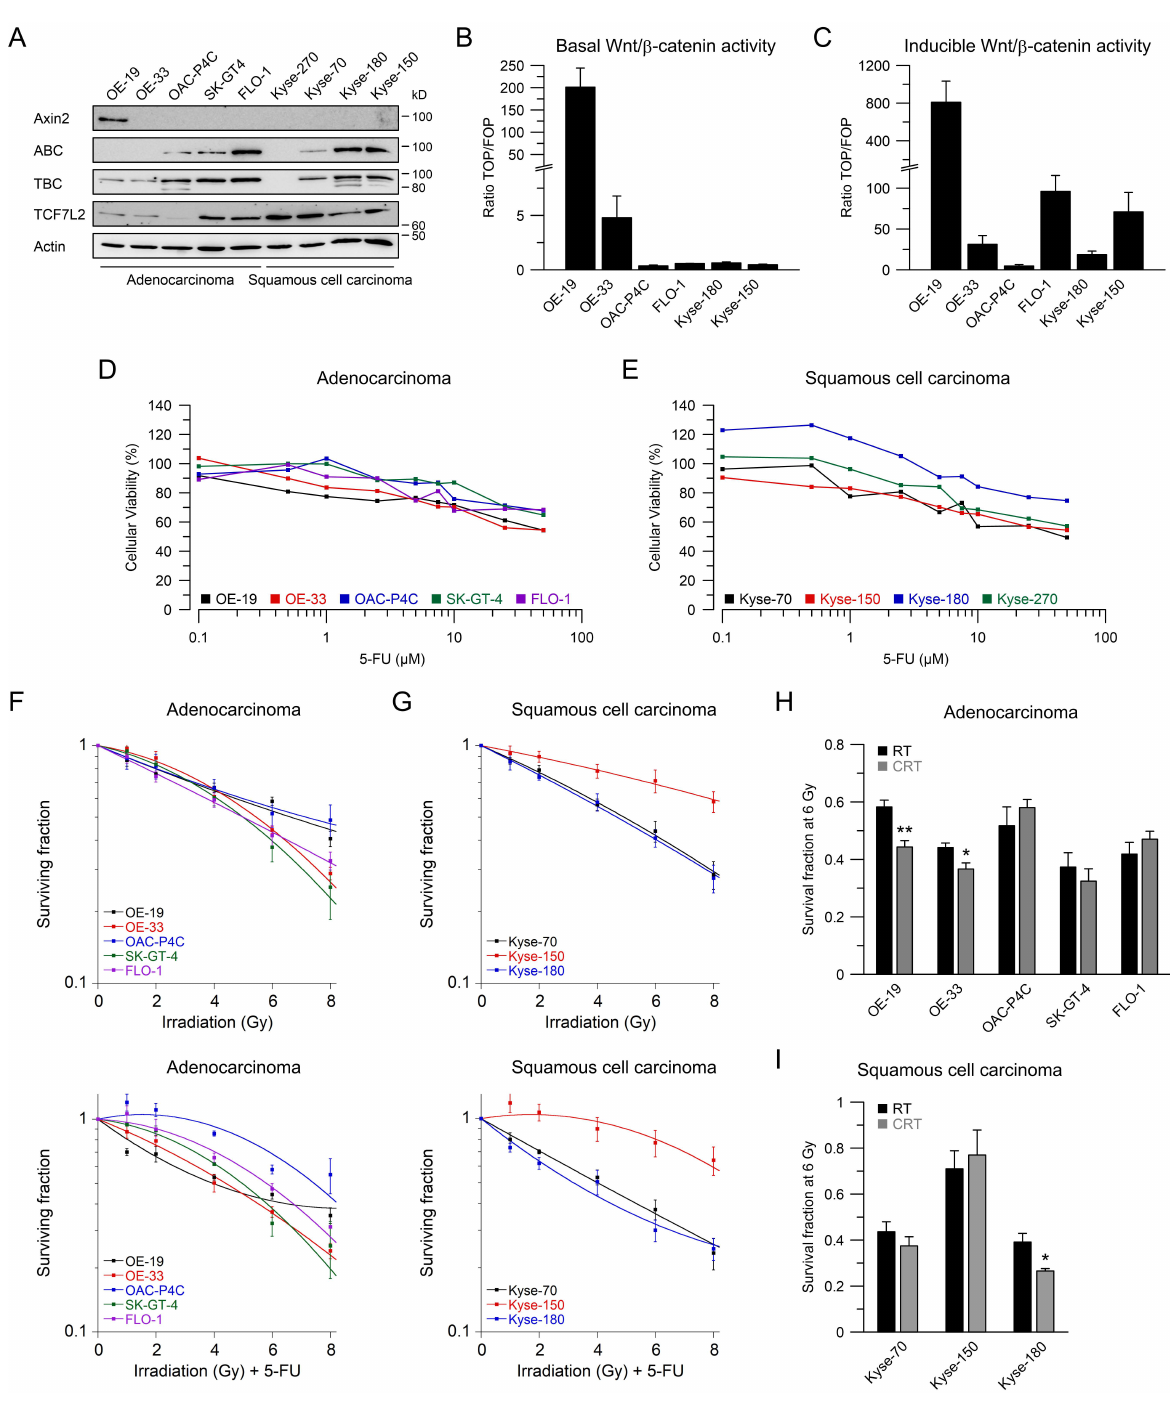
Figure 1. Characterization of Wnt/ β -catenin pathway activity, and irradiation sensitivity of esophageal cancer cell lines. ( A ) Nine esophageal cancer cell lines were analyzed for expression of Wnt-related proteins by immunoblotting; ( B , C ) Selected cell lines were analyzed for basal Wnt/ β -catenin transcriptional activity, ( B ) or inducible transcriptional activity ( C ), measured by dual luciferase reporter assays; ( D , E ) Dose-response analysis for different concentrations of 5-FU 24 h after treatment in adenocarcinoma ( D ) or squamous cell carcinoma cell lines ( E ); ( F , G ) Adenocarcinoma ( F ) or squamous cell carcinoma cell lines ( G ) were cultured in colony formation assays (CFA) to determine their survival following irradiation (RT, upper panel) or irradiation in the presence of 5-FU (CRT, lower panel); ( H , I ) Comparison of RT and CRT survival fractions at 6 Gy. Data are presented as mean ± s.e.m. from at least n = 3 independent biological replicates. * p < 0.05, ** p < 0.01, unpaired two-sample Student’s t -test. For p -values see Table